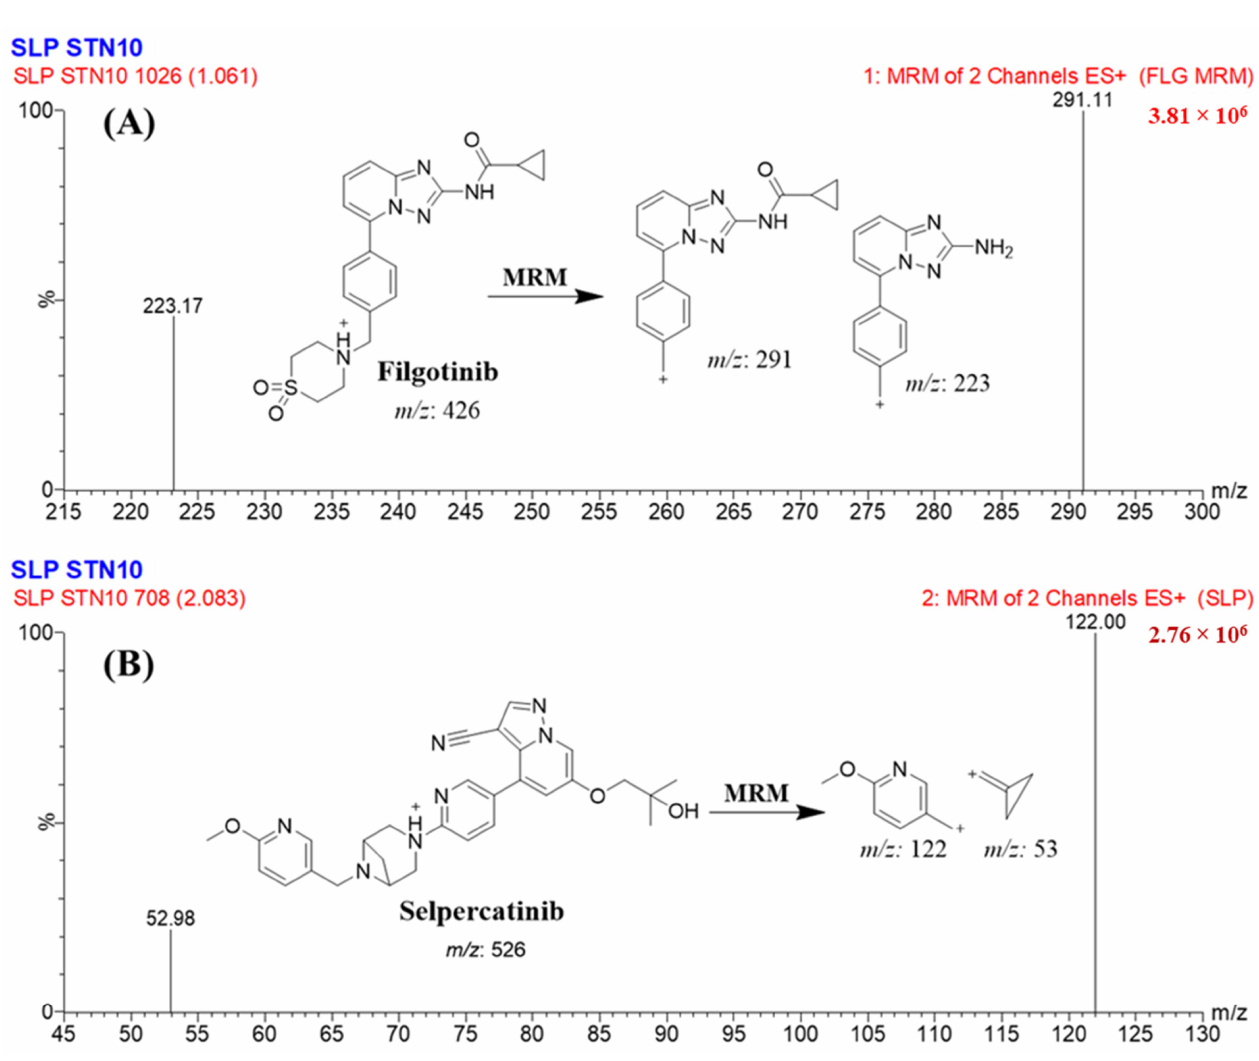
Figure 5. FLG MRM mass spectra. ( A ) SLP MRM mass spectra. ( B ) Exhibiting the proposed fragmentation pattern. Table 5. MRM parameters for the quantification of SLP and FLG